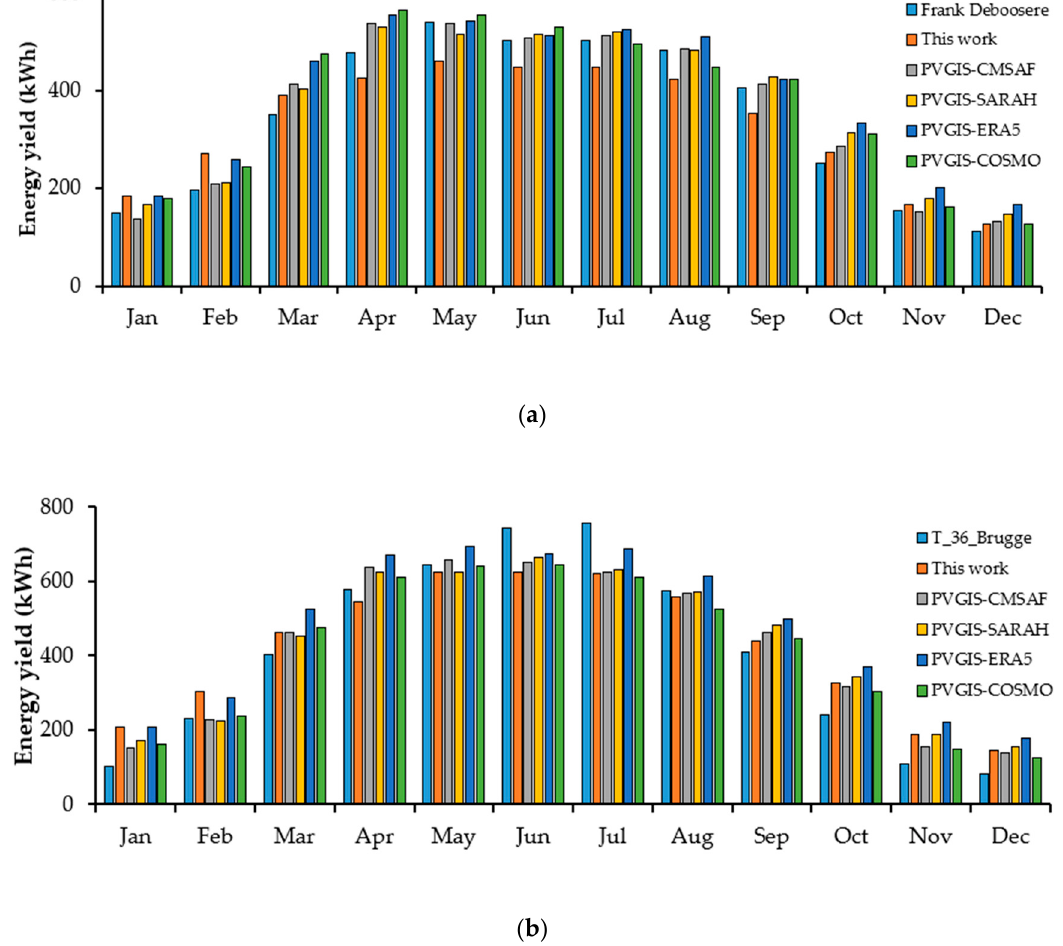
Figure 6. A comparison of monthly energy yield between this study and two actual installation PV-systems in Flanders, Belgium as well as Photovoltaic Geographical Information System (PVGIS) models. ( a ) Monthly harvesting of Frank Deboosere installation; ( b ) Monthly harvesting of T_36_Brugge installation.